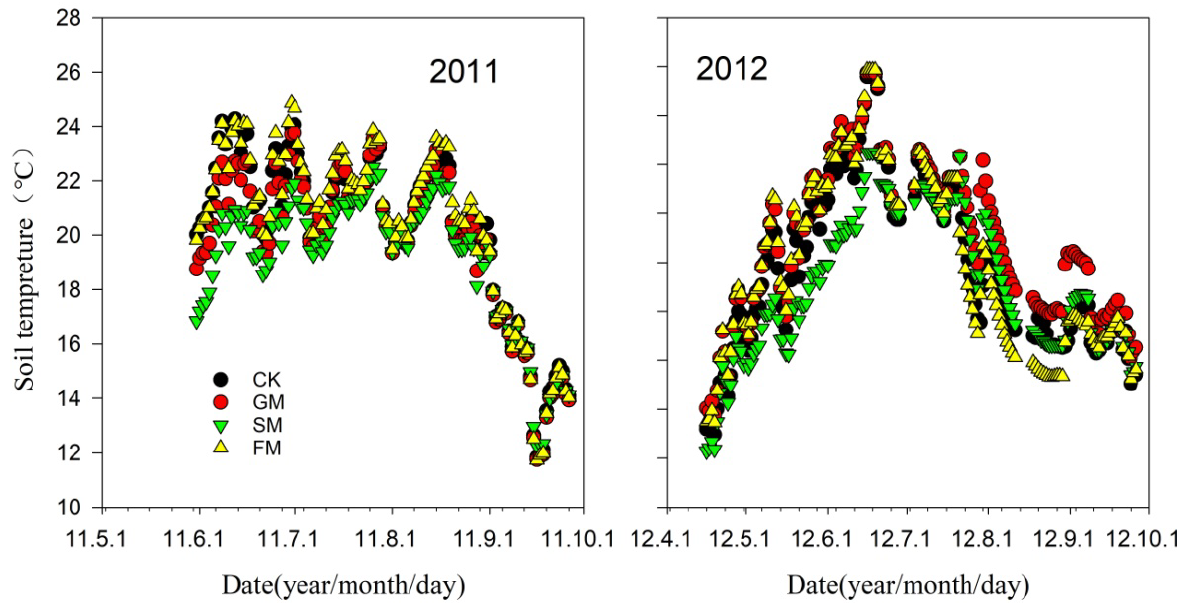
Figure 1. The mean soil temperature at a depth of 20 cm for the different mulching treatments in 2011 and 2012.